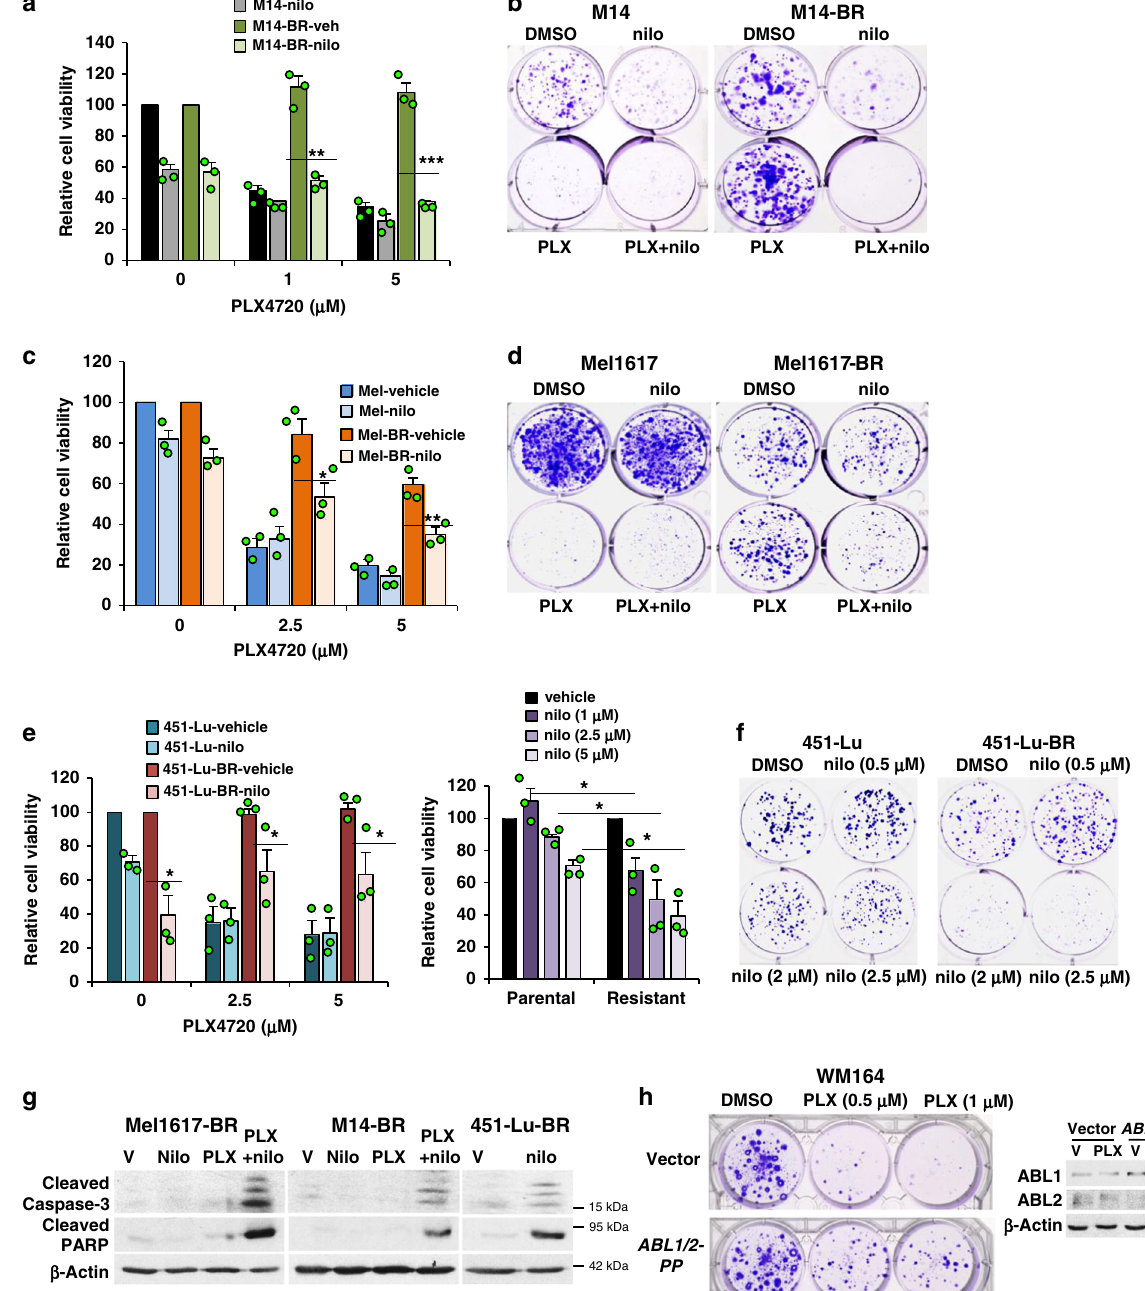
Fig. 2 ABL1/2 inhibition reverses resistance to BRAF inhibitors. a , c , e Viability (CellTiter Glo) assays for cells treated with vehicle (veh) or nilotinib (nilo) alone ( e (right)) in the absence/presence of BRAFi, PLX4720 (doses shown) for 72 h ( a , c , e (left)). Nilotinib doses: a 5 or 6 μ M; c , e 5 μ M. Results are mean ± SEM for three independent experiments performed in triplicate. Additional drug doses are shown in Supplementary Fig. 2a, b. * p < 0.05, ** p ≤ 0.01, *** p < 0.001 using two-sample t -tests (two sided). Actual p values (left → right): a 0.0029, 0.00016; c 0.039, 0.0068; e (left) 0.016, 0.043, 0.015; e (right) 0.019, 0.035, 0.035. b , d , f Colony assays. Cells were treated with nilotinib ( b 4 μ M, d 3 μ M; f doses shown) and/or PLX4720 (2.5 μ M) for 7 days, wells washed, plates incubated additional days without drugs (451-Lu/M14-5d; Mel1617-6d) until colonies were well visualized, at which time they were stained with crystal violet. g Cells were treated with the indicated drugs for 96 h and detached and attached cells lysed and subjected to western blotting. Nilotinib: Mel1617-BR, 4 μ M; M14-BR, 451-Lu-BR, 5 μ M. PLX: Mel1617-BR, 4 μ M, M14-BR, 3 μ M. Representative blots from n = 2 independent experiments are shown. V = vehicle. h Low-invasive WM164 cells, which lack endogenous activated ABL1/2 and harbor BRAF-V600E , were engineered to stably express constitutively active forms of ABL1 and ABL2 (PP) or vectors. Cells were plated, treated with vehicle or the BRAFi, PLX4720, for 7 days, wells washed, incubated with media without drug for 9 days, stained with crystal violet, and colonies manually counted. Levels of ABL1/2 proteins are shown on the right. Cells were maintained in the presence of PLX but removed from drug two days prior to plating for experiments. Colony assay shown is representative of n = 4 (0.5 μ M) or n = 2 (1 μ M) independent experiments (see Supplementary Fig. 2h). V = vehicle =